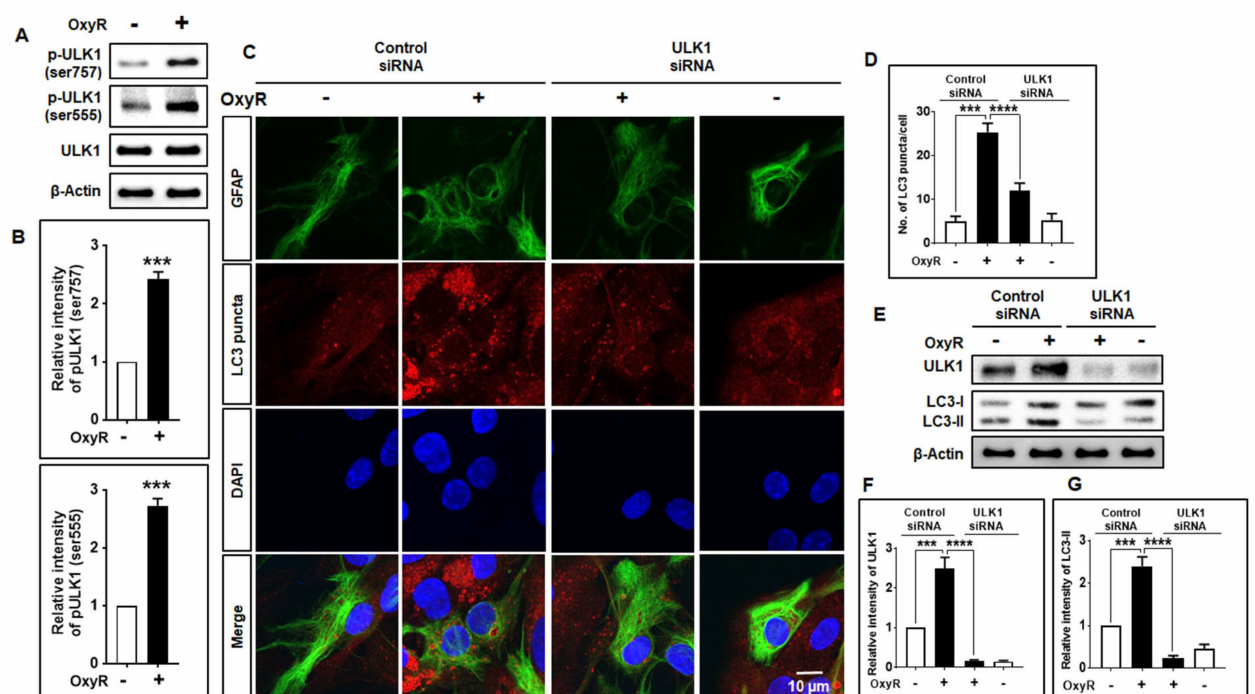
Figure 4. OxyR-mediated autophagy initiated via the ULK1-dependent pathway in cortical astrocytes. ( A ) Astrocytes were cultured in the presence or absence of OxyR (10 µ M) for 24 h. ULK1, pULK1 (ser757), and pULK1 (ser555) expression levels were examined by Western blotting. ( B ) Densitometry analysis was performed by using ImageJ software. Statistical analysis was accomplished by conducting one-way ANOVA. ( C ) Control siRNA and ULK1 siRNA were transfected for 48 h and incubated with 10 µ M of OxyR for 24 h. Astrocytes were fixed and stained with Alexa Fluor-conjugated anti- GFAP mouse mAb (green) and Alexa Fluor-conjugated anti-LC3 antibody (red). Images were acquired using a confocal microscope. ( D ) LC3 puncta were counted in three independent, randomly selected areas, and at least 5 cells were counted. ( E ) Representative ULK1 and LC3 expression levels were determined by Western blotting. ( F , G ) Densitometry and statistical analysis were performed using ImageJ and one-way ANOVA, respectively. Data are presented as mean ± SEM. *** p < 0.001, **** p < 0.0001. OxyR, oxyresveratrol; ULK1, unc-51-like autophagy activating kinase 1; p-ULK1, phosphorylated ULK1; siRNA, small interfering RNA; GFAP, glial fibrillary acidic protein; LC3, microtubule-associated protein light chain 3; DAPI, the nuclear marker 4 (cid:48)